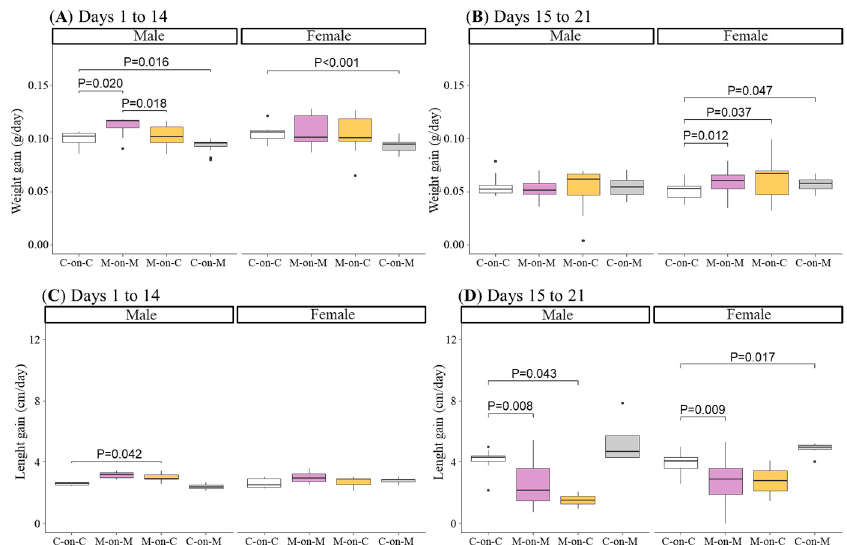
Figure 2. Body weight from day 1 to 14 of lactation ( A ) and from day 15 to 21 of lactation ( B ), and body length gain from day 1 to 14 of lactation ( C ) and from day 15 to 21 of lactation ( D ) in male and female rats from MUN and Control mothers. MUN, maternal undernutrition during gestation; C-on-C, control pups fostered by their mothers (34 males and 38 females); M-on-M, MUN rats fostered by their mothers (32 males and 40 females); C-on-M, control rats fostered by MUN mothers (21 males and 27 females); M-on-C, MUN rats fostered by a control mother (25 males and 23 females). Data show the median and interquartile range [Q1; Q3] and the showed p -Value (P) was extracted from Dunnett’s post-hoc pairwise comparison test when the Kruskal-Wallis test was P < 0.05. Dots show